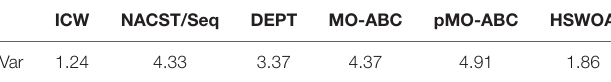
TABLE 4 | Comparing the melting temperatures of the various algorithm sequences.